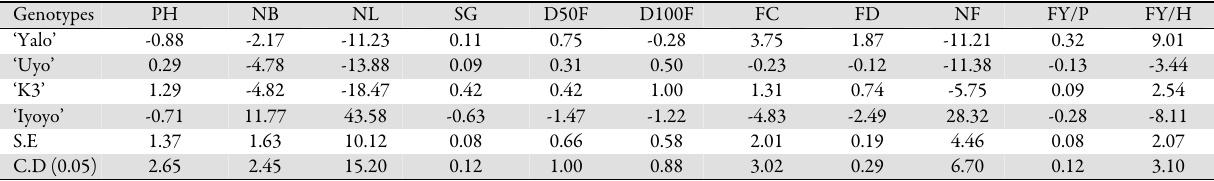
Table 4. General combining ability estimate on the agronomic traits of genitors eggplant genotypes Genotypes PH ‘Yalo’ ‘Uyo’ ‘K3’ ‘Iyoyo’